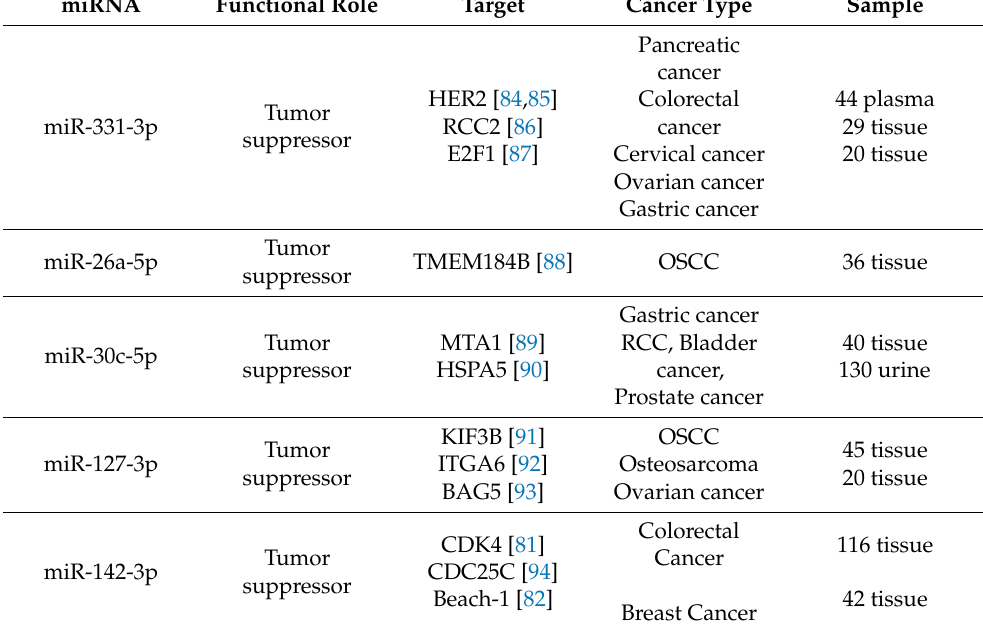
Table 5. Functional roles and validated targets of miRNAs associated with overall survival, prognosis, and